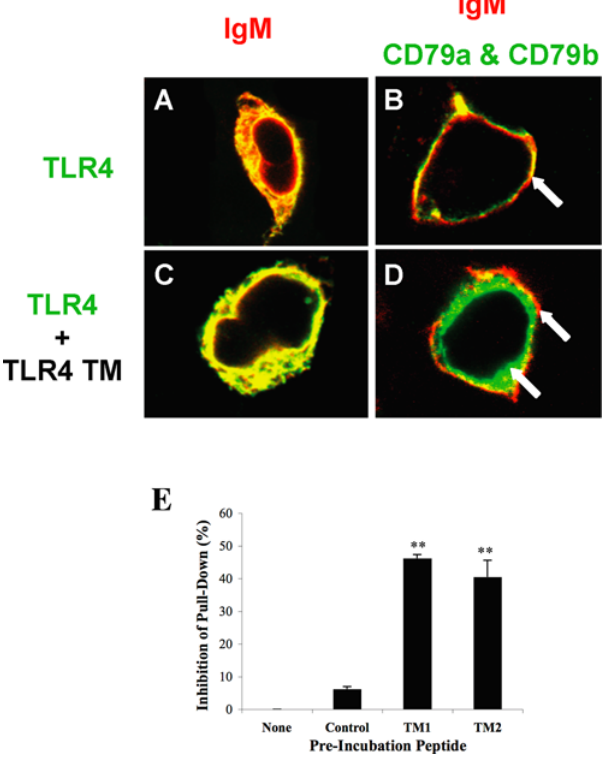
Figure 7. The TLR4 transmembrane region competitively inhibits the TLR4/BCR association. A–D. HEK293 cells were co- transfected with HA-tagged full length TLR4, along with the BCR (A and C) or the BCR and CD79a/CD79b constructs (B and D). In addition, cells in C and D were also cotransfected with a construct coding for the unlabeled TLR4 TM region. Cells were prepared as in Figure 5 and all panels represent the overlay of green (anti-HA staining) and red (anti- IgM staining) channels. The non-tagged TLR4 TM construct competed with the HA-TLR4 TM-IC, inhibiting its translocation to the cell membrane (compare B to D). E. Purified B cells from TLR4 WT mice were pre-incubated for 2 hr with peptides TM1 or TM2 corresponding to the transmembrane region of TLR4 or with a control peptide, activated with 1 m g/ml of LPS for 1 hr, and TLR4 was immunoprecipitated with a specific biotinylated antibody and captured on streptavidin-coated microplates. Bound IgM was detected with a specific HRP-conjugated antibody as in figure 5C. ** P , 0.01 vs. control-treated